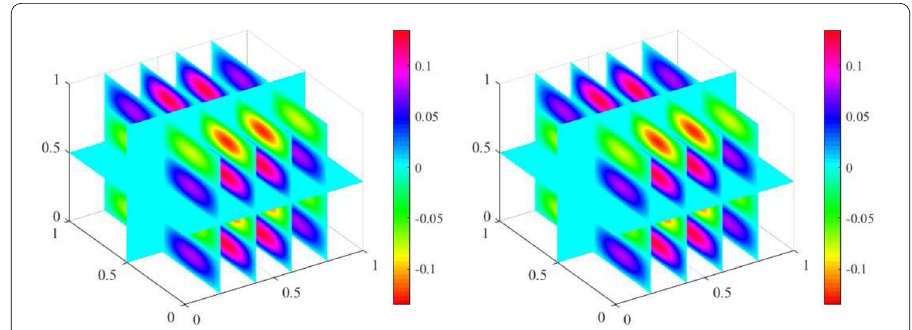
Figure 10 The numerical solution of CFDS6-SSM (left-hand side) and E-CFDS6-SSM (right-hand side) when J = 41 and t = 2 for SP 4